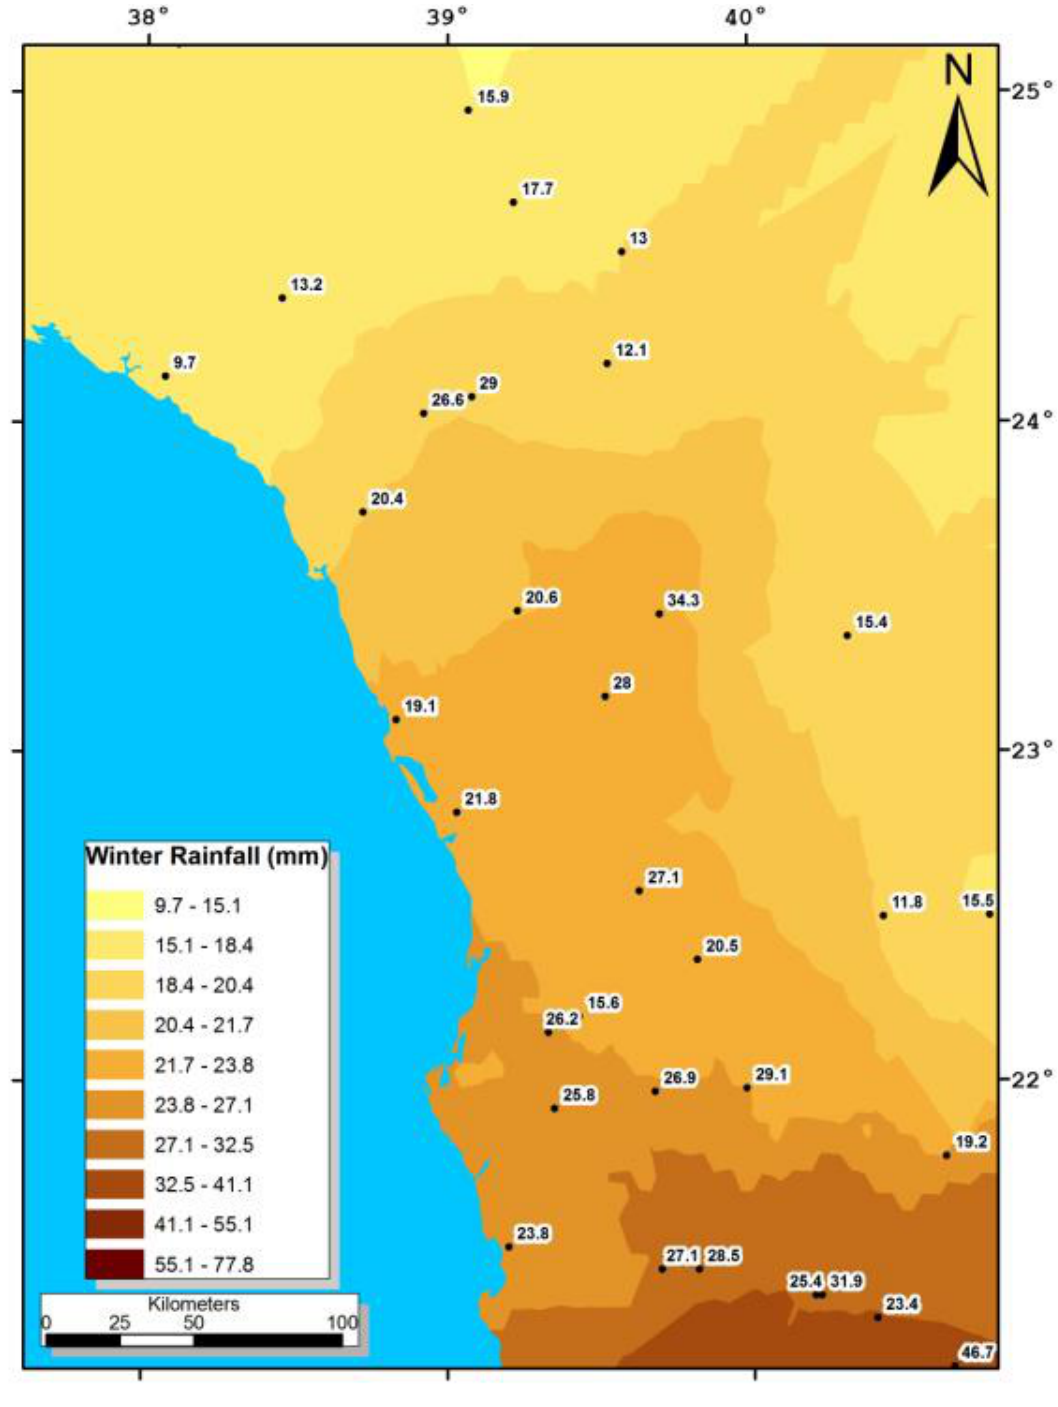
Figure 10. Isohyetal map for winter rainfall